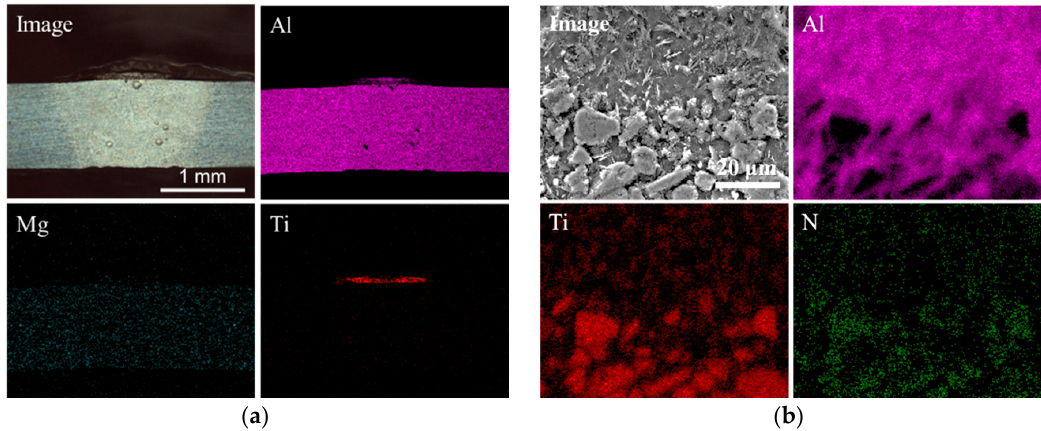
Figure 6. EDS mapping analysis of ( a ) the macro cross-section and ( b ) the top layer of laser-welded TiN-coated BM.